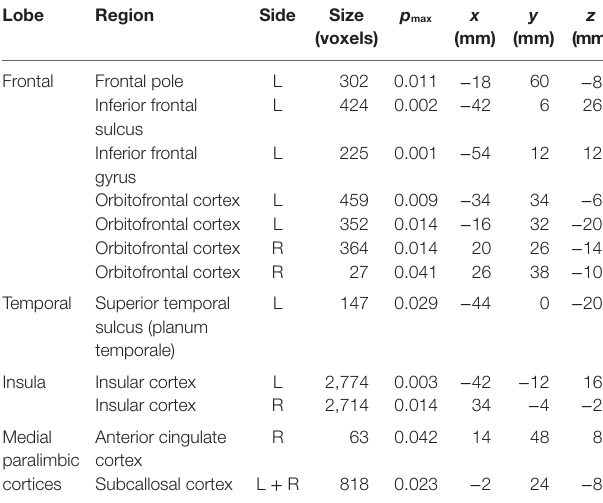
L, left; R, right. The cluster sizes are indicated in voxels in standard space (voxel size: 2 mm 3 isotropic). The maximal p-value is reported in the fifth column. Peak p-value coordinates are reported in the MNI152 standard space. There were two partly separable volumetric clusters detected in the area of the orbitofrontal cortices on both sides. The affected areas of the perisylvian cortex on the right side seemed to be extending partly to the parietal lobe (onto the operculum and supramarginal gyrus), beside this the temporal deficits migrate lightly onto the parahippocampal areas.